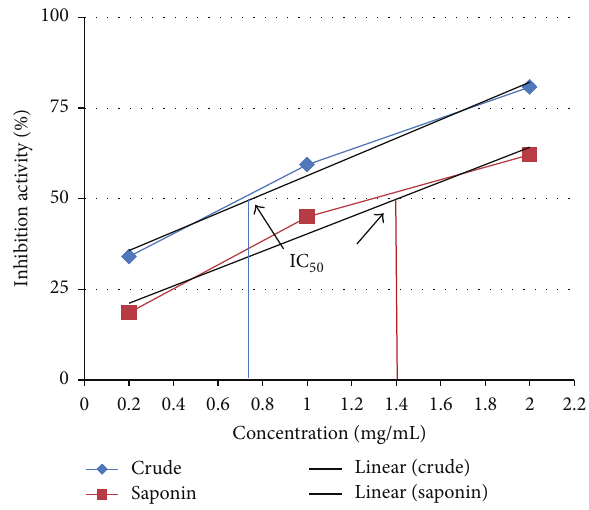
Figure4:IC 50 valueinBCBassayoftotalsaponinandcrudeextracts of mother plant tuber of C. borivilianum .